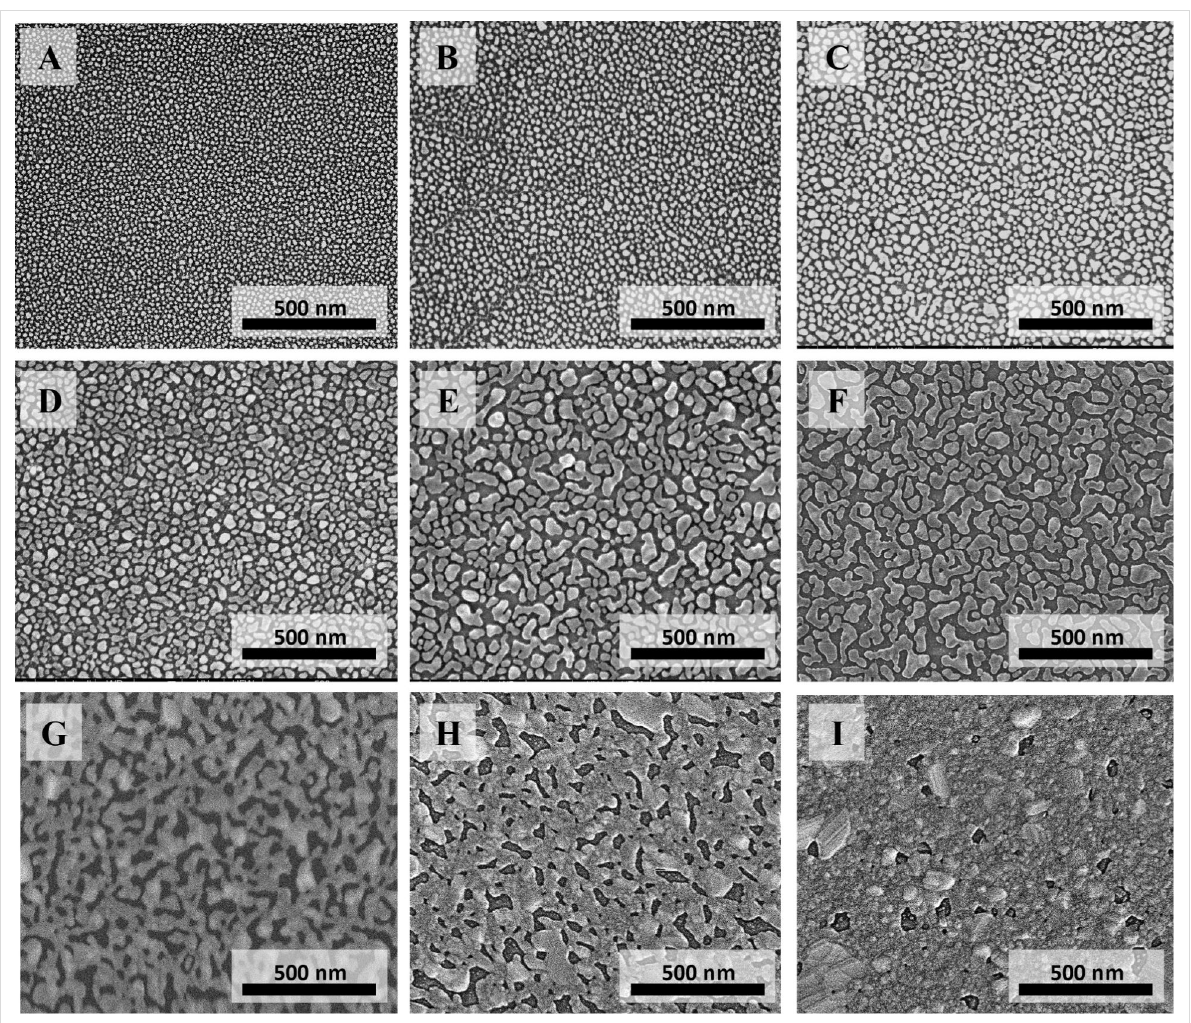
Figure 1: (A–I) SEM images of SSFs with different Ag thickness.